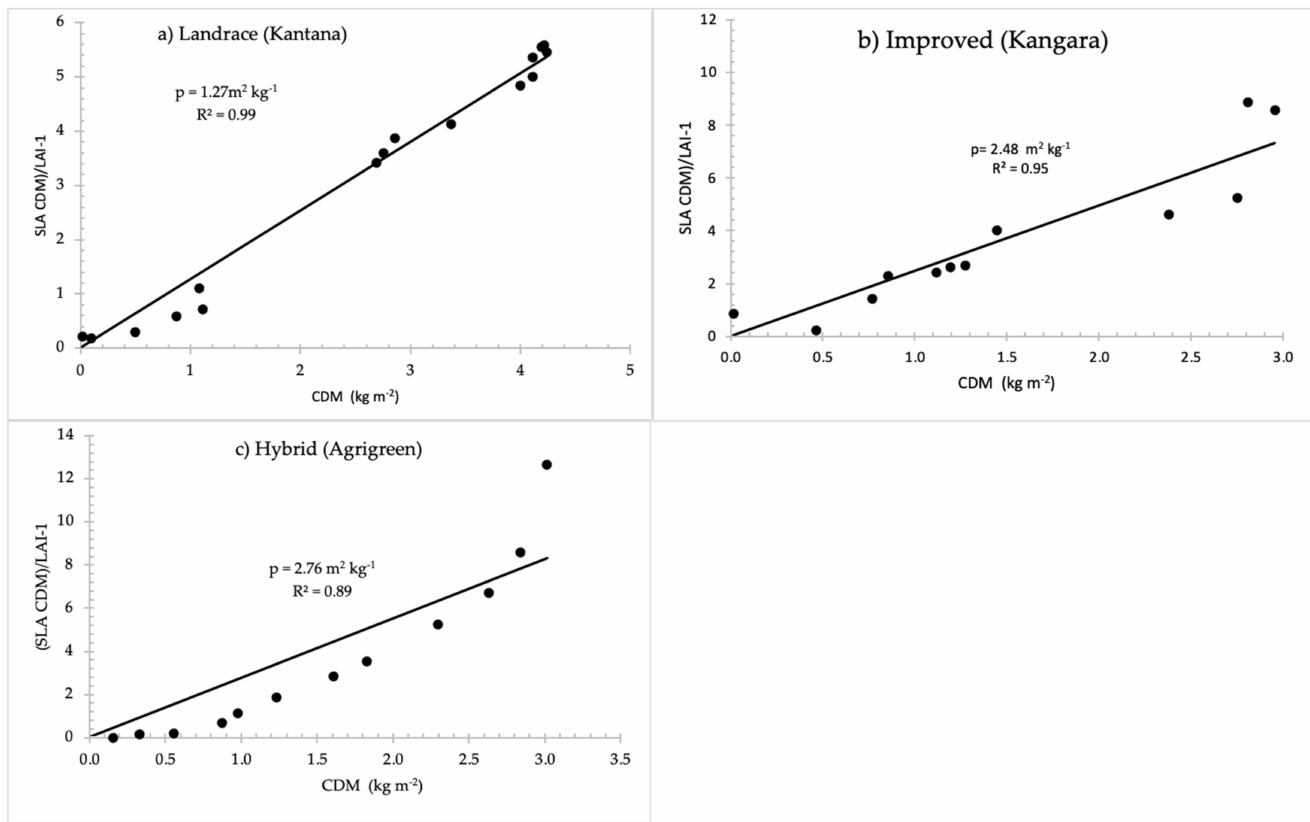
Figure 3. Determination of the stem-leaf dry matter partitioning parameter (p) as a function of canopy dry matter (CDM), specific leaf area (SLA) and leaf area index (LAI) for pearl millet varieties: ( a ) landrace, ( b ) improved and ( c ) hybrid, with the slope of the regression line (p) and the coefficient of determination (R 2